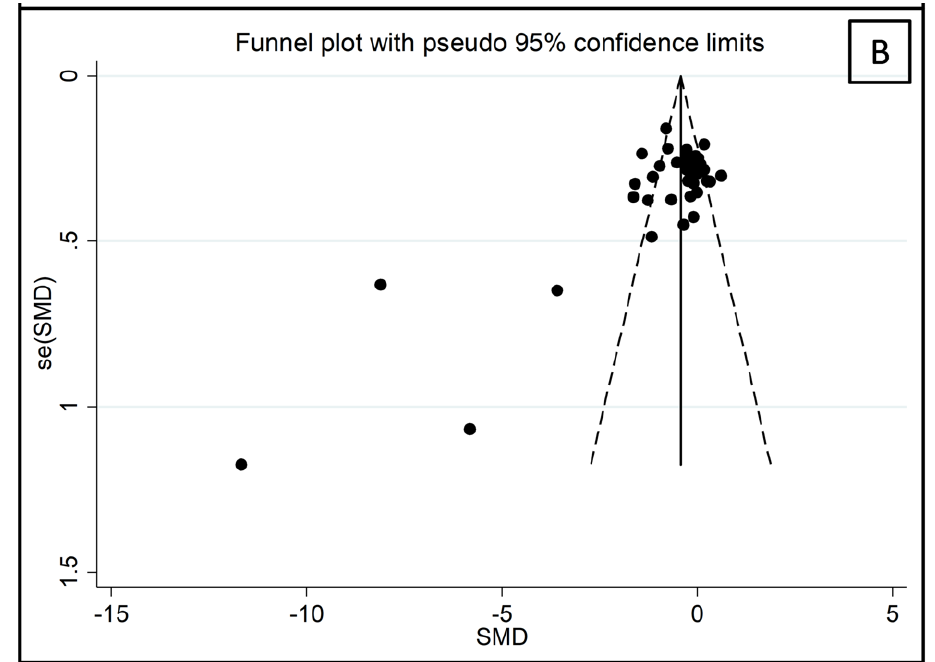
Figure 12. ( A ) Sensitivity analysis of the association between E-Selectin and statin treatment. The influence of individual studies on the overall standardized mean difference (SMD) is shown. The middle vertical axis indicates the overall SMD, and the two vertical axes indicate the 95% confidence intervals (CIs). The hollow circles represent the pooled SMD when the remaining study is omitted from the meta-analysis. The two ends of each broken line represent the 95% CIs. ( B ) Funnel plot of studies investigating E-Selectin concentrations before and after statin treatment.